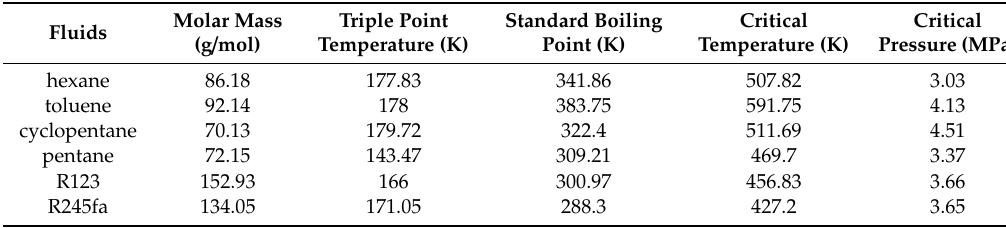
Table 1. Major properties of working fluids.